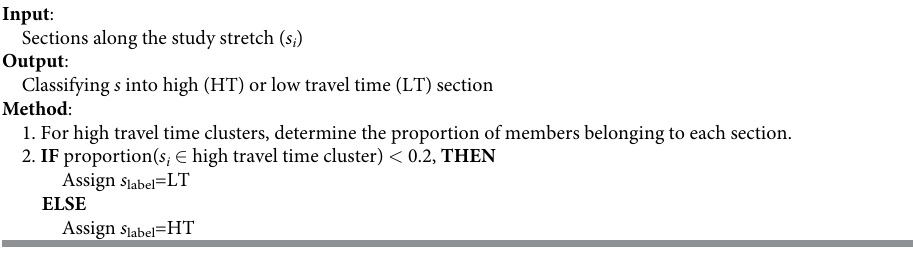
Table 3. Classification into low and high travel time